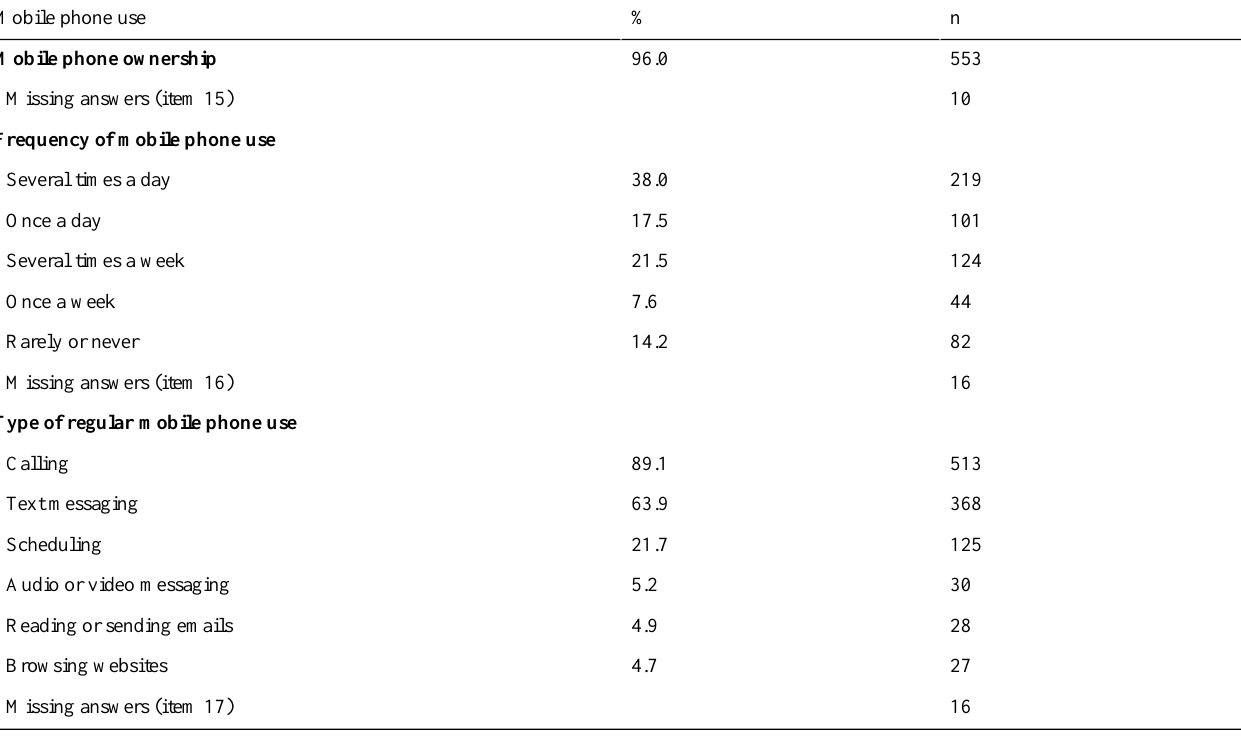
Table 3. Mobile phone use by patients with multiple sclerosis (n = 586) a .